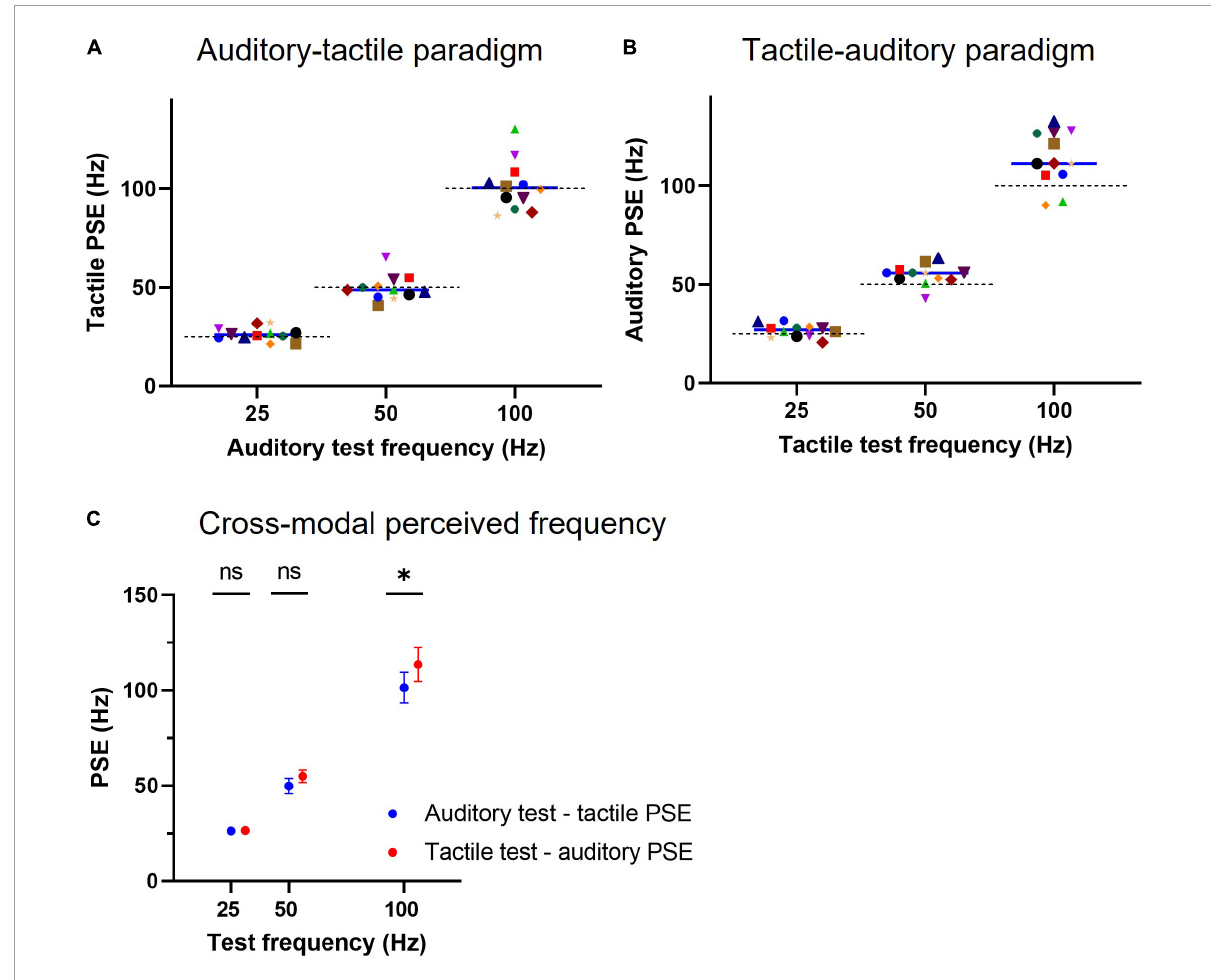
FIGURE3 Cross-modal point of subjective equality (PSE) for regular tactile and auditory stimuli. (A) Individual subject PSEs obtained for auditory test conditions using tactile comparisons (auditory-tactile paradigm). A tactile PSE represents the frequency of a vibrotactile pulse train that is equally likely to be judged higher or lower than the auditory test stimulus. A solid line indicates a median PSE ( n = 12) value for a test frequency, whereas a dashed line represents the expected unimodal PSE (or the physical frequency) of the test stimulus. (B) Individual subject PSEs for tactile test conditions using auditory comparisons (tactile-auditory paradigm), conventions as in panel (A) . (C) Cross-modal equivalent mean frequencies for both auditory and tactile stimuli of identical frequency, * represents p < 0.05 and error bars indicate ± 95%